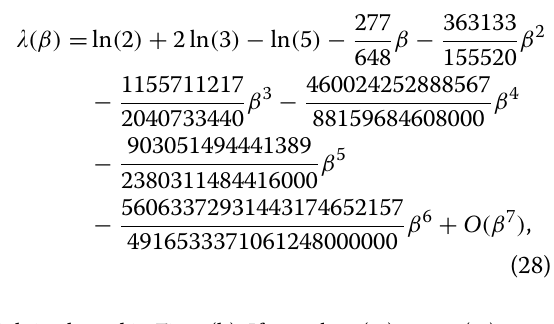
) p ( ) 0.5. The Monte carlo results are marked with (blue) circles while the analytic approximation is plotted + = − =